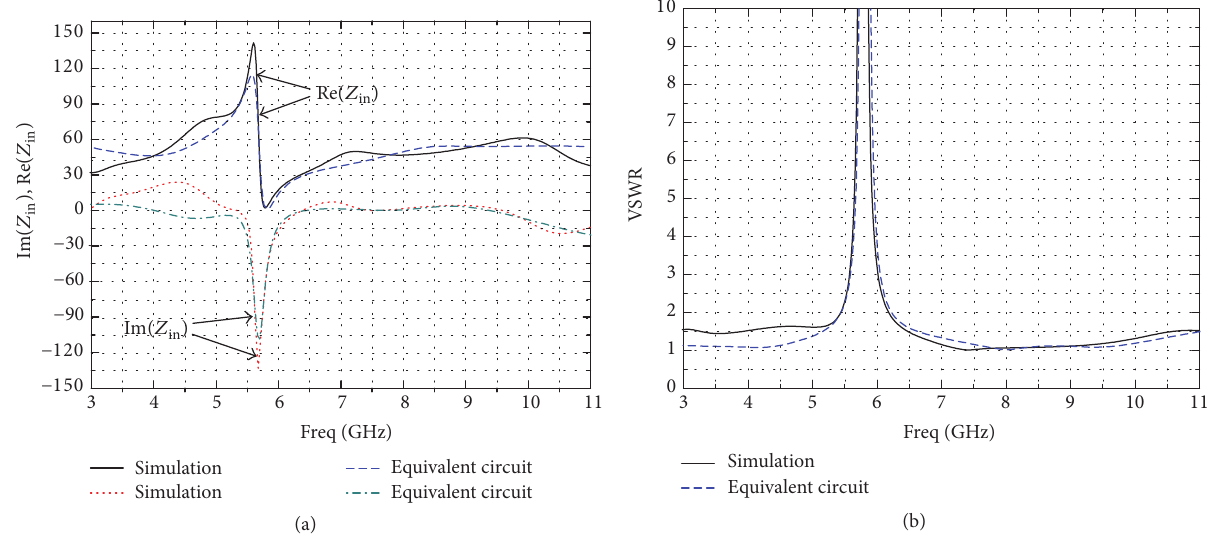
Figure 9: Comparison of simulated and calculated result for the equivalent circuit (a) input impedance and (b) VSWR.